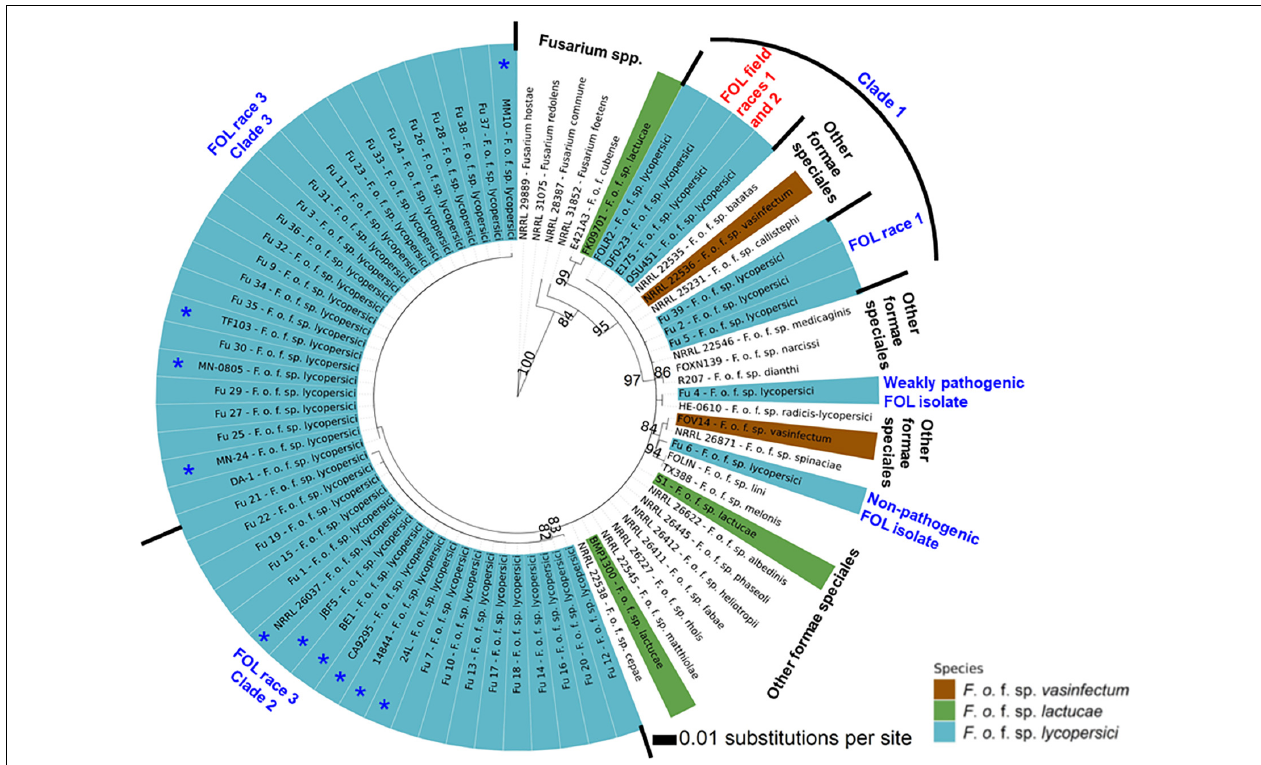
FIGURE 7 | The Maximum-likelihood phylogenetic trees of the 38 isolates of Fusarium oxysporum f. sp. lycopersici (FOL) sampled from tomato in the greenhouses in North Carolina generated from the translation elongation factor 1- α encoding gene tef1- α sequences. For comparison purposes, publicly available the tef1- α gene sequences of field isolates of FOL and other formae speciales of F. oxysporum and Fusarium spp. from the United States and other countries were downloaded from the National Center for Biotechnology Information database GenBank (https://www.ncbi.nlm.nih.gov/genbank/). The tree topology was obtained through maximum-likelihood with 1,000 replications using the Jukes-Cantor model. Phylogenetic trees were assembled with each test isolate using the T-BAS v.2.0 (Carbone et al., 2017). Innermost ring refers to principal component analysis and the numerical values above branches are bootstrap values. Outer ring represents FOL isolates sampled from greenhouses and field isolates from the United States and other countries as well as other formae speciales of F. oxysporum and Fusarium spp. Asterisk (*) before the isolate number indicates previously reported FOL isolates from fields ( Table 2 ). The isolates joined by dotted lines within the ring indicate these isolates are genetically similar while solid lines represent high nucleotide polymorphisms. Parsimony bootstrap values ( > 80%) are shown above the